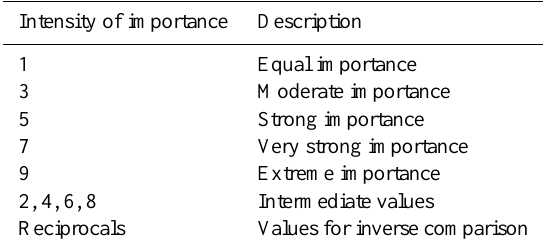
Table 4. Scale of